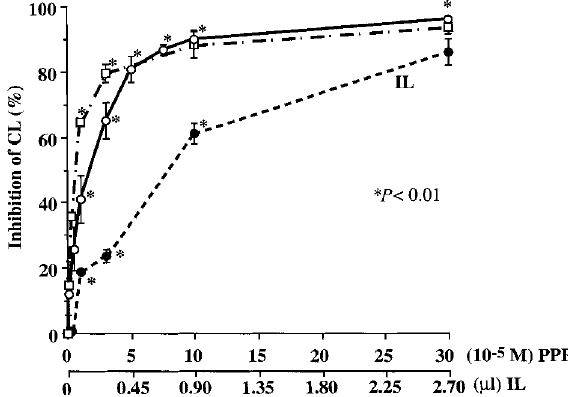
FIG. 3. Inhibition (±SD) of the CL of NaOCl by pure PPF dissolved in carbitol (